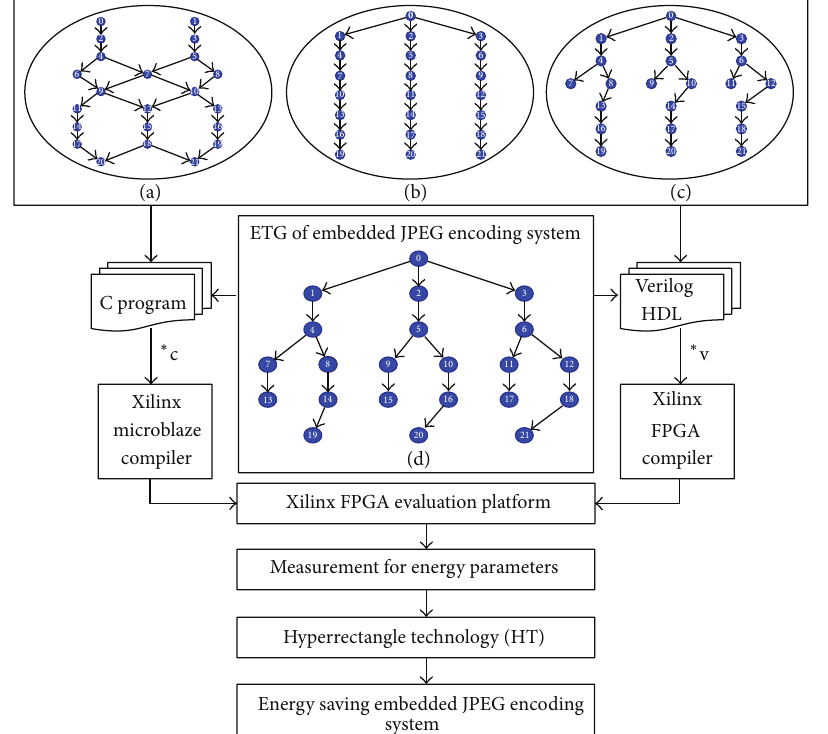
Figure 4: Flow chart of experimental setup.